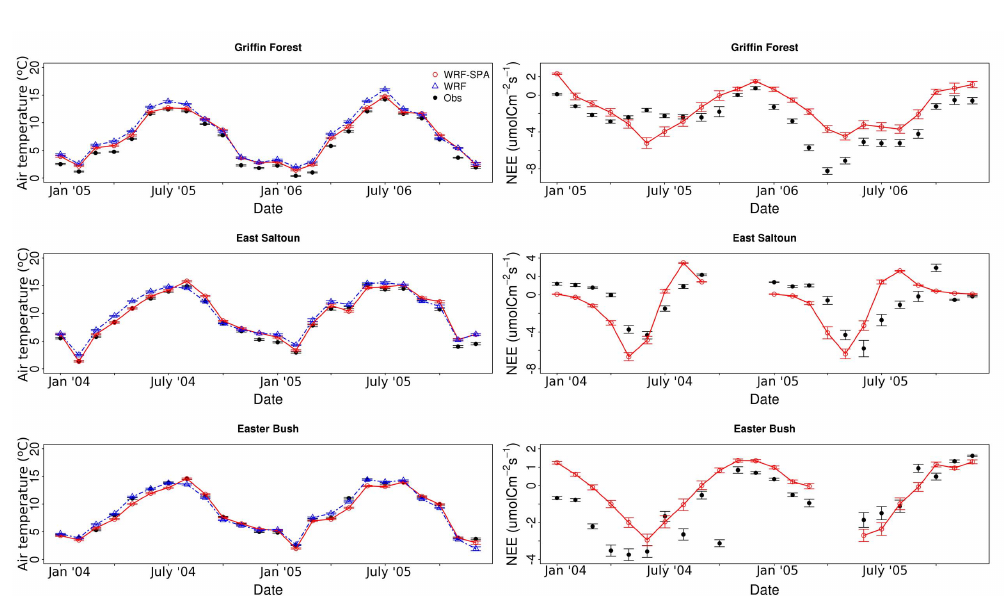
Fig. 2. Monthly mean values for air temperature and net ecosystem exchange by observations, WRF-SPA and WRF. Error bars are ± 1 standard error, accounting for temporal averaging